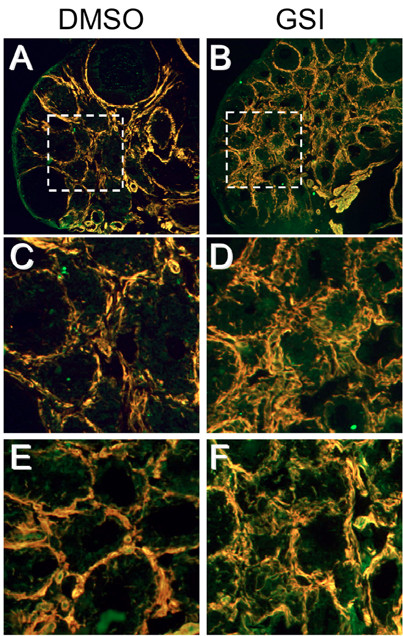
Compound E inhibition of Notch signaling increased vascular smooth muscle cells (VSMC) density and altered VSMC organization in the ovarian stroma. A-D) Immunofluorescence staining (10× magnified) for Notch3 (green) and α-SMA (red). C, D) enlargement of boxes areas in upper panels (20× magnified). Please note increased thickness and disorganized appearance of VSMCs in B and D. E, F) PECAM (green) and α-SMA (red). Please note disorganisation and failure to overlap in F (20× magnified).